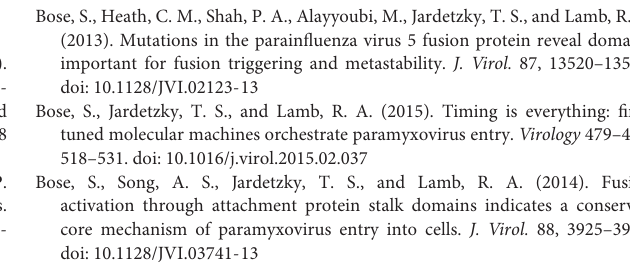
FIGURE S7 | Immunofluorescent staining the chimeric HN proteins used in Figure 5A . Subconfluent BHK cells grown on glass coverslips in six-well culture plates were transfected with 2.0 µ g/well of the pcDLSRa expression vector encoding each HN protein. After 24 h of incubation at 37 ◦ C, the cells were fixed with 4% paraformaldehyde and the HN proteins were visualized as described in the legend for Supplementary Figure S6 by using MAb 173-1A or MAb 127A-1. Bar, 100 µ m. FIGURE S8 | Efficiency of fusion promotion by the HN proteins. The fusion indices given by the HN proteins shown in Figure 6C (A) , Figure 6B (B) , and Figure 7C (C) are normalized to their cell surface-localization levels. The statistical significance was evaluated by one-way ANOVA as described in the section “Materials and Methods” ( ∗∗∗ p < 0.01, n = 10). ns, not significant. FIGURE S9 | Immunofluorescent staining the chimeric HN proteins used in Figure 6A . Subconfluent BHK cells grown on glass coverslips in six-well culture plates were transfected with the expression vector encoding each HN protein. After 24 h of incubation at 37 ◦ C, the cells were fixed with 4%